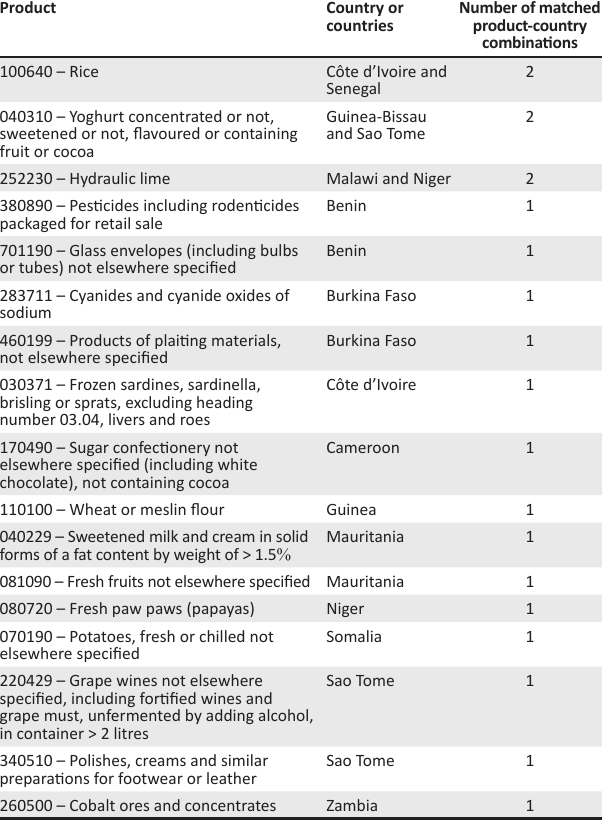
TABLE 6: Matched product-country combinations with non-utilised sustained export potential in SSA.